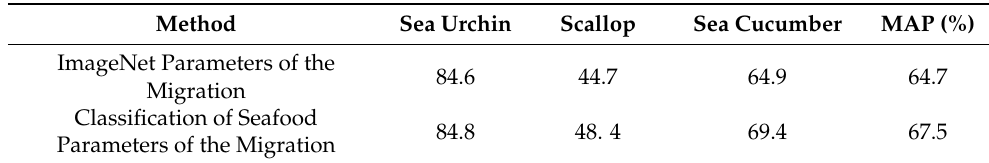
Table 4. Accuracy comparison of detection network, with or without parameter migration, in different